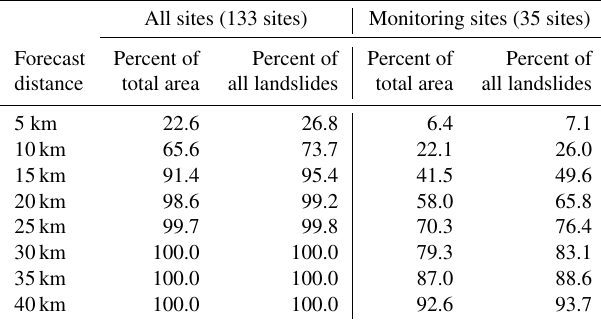
Table 3. Percentage of country (area of Switzerland) and number of landslides (percentage of all landslides recorded from 1981 to 2019) covered by the soil moisture simulations and measurements as a function of the forecast distance